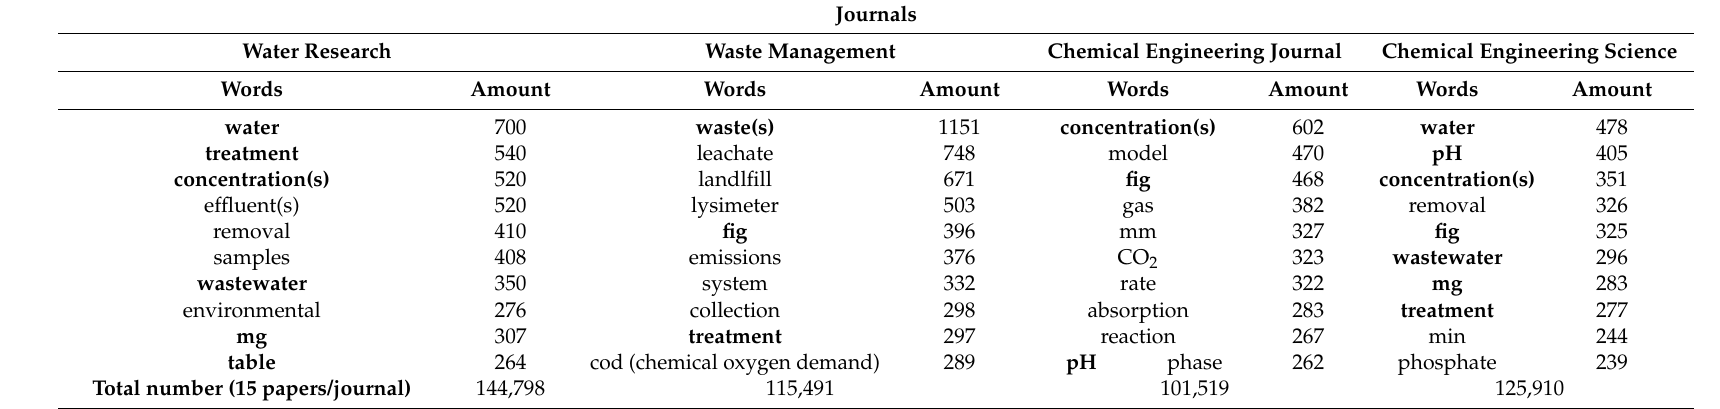
Table 2. The top ten words occurring in each journal and their total number of